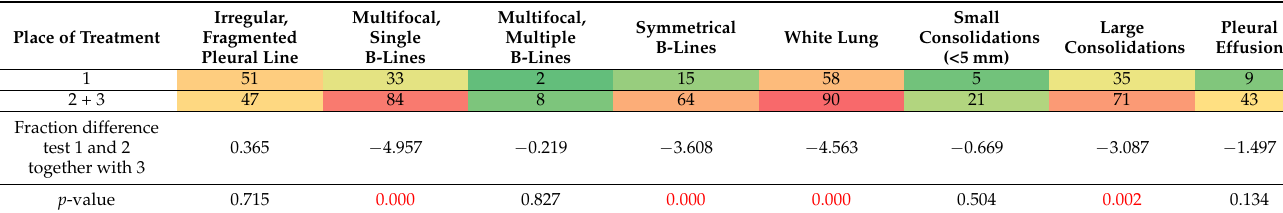
Table 2. Incidence of specific LUS findings in ambulatory and hospitalized patients. 1—ambulatory; 2—department of internal medicine; 3—intensive care